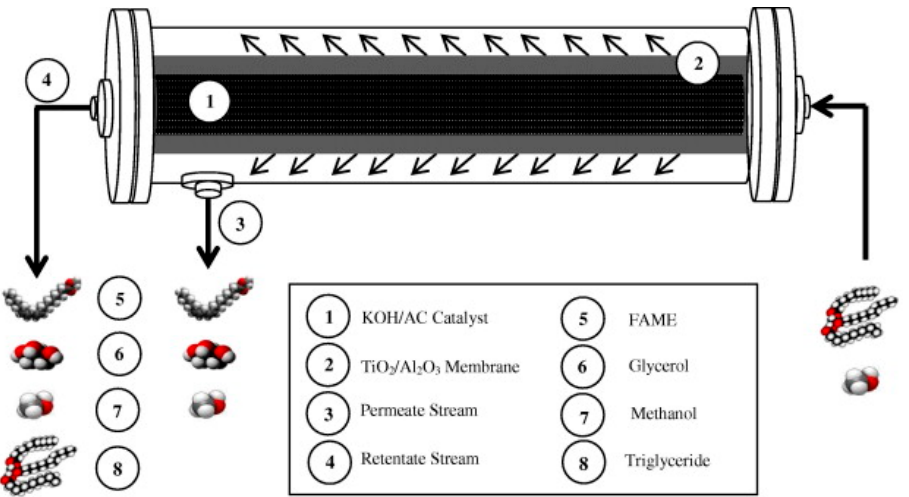
Figure 15. Combination of heterogeneous base transesterification and triglyceride separation in the packed bed membrane reactor (Copyright of Elsevier, see [49]).